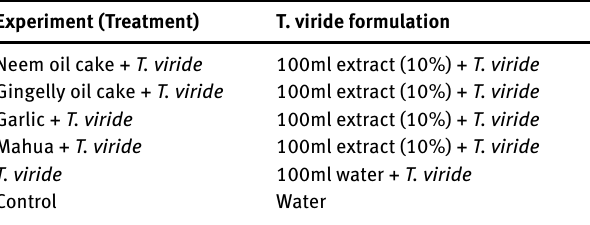
Table 2: Experimental setup of T. viride formulations to seedlings of chilli variety